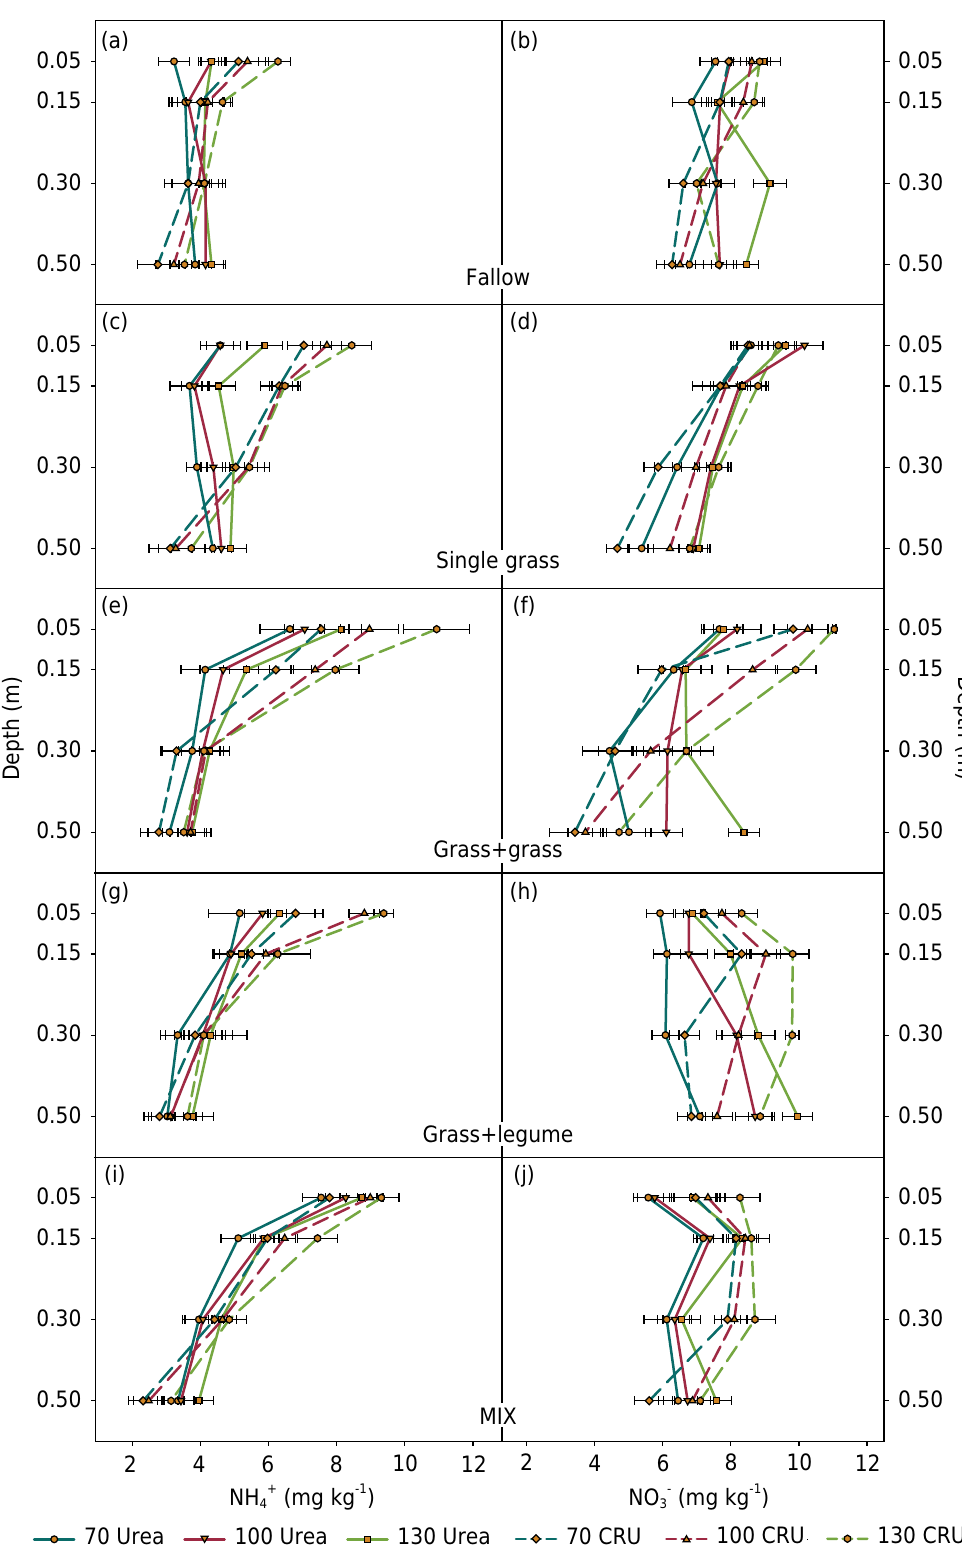
Figure 2. Inorganic nitrogen contents in the soil (NH 4+ and NO 3- ) after cotton harvest from the 2018/2019 crop season. Horizontal bars represent standard error of the